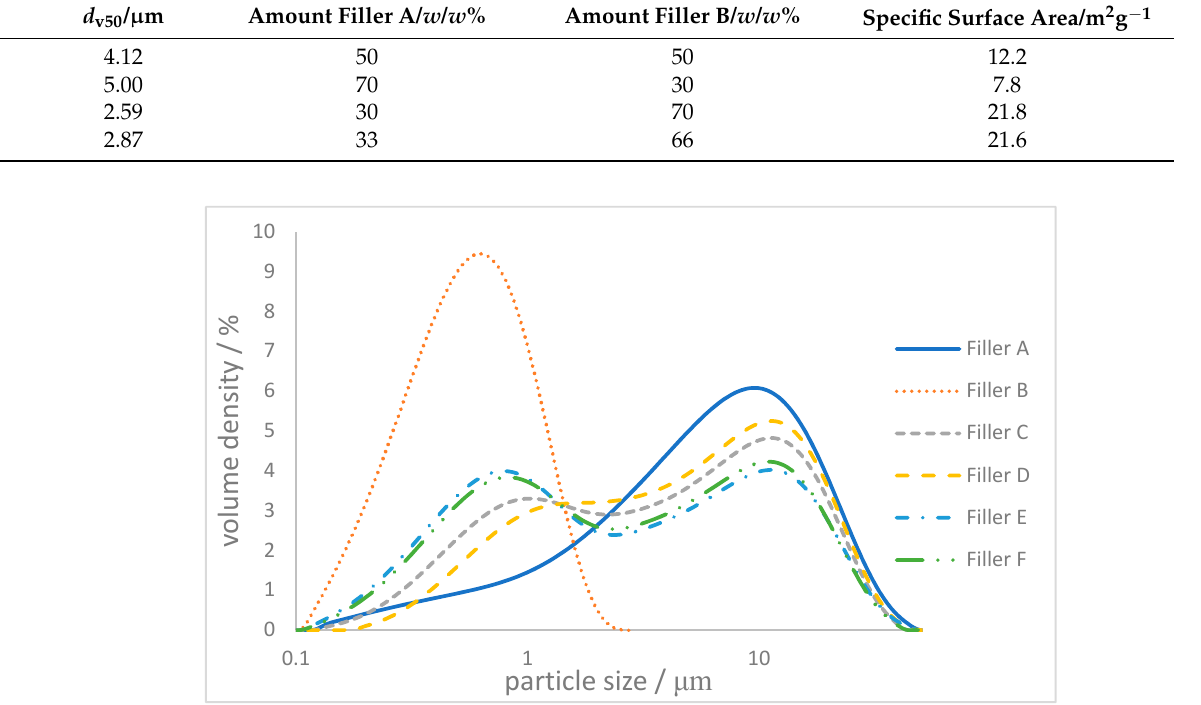
Figure 1. Particle size distribution of developed fillers.